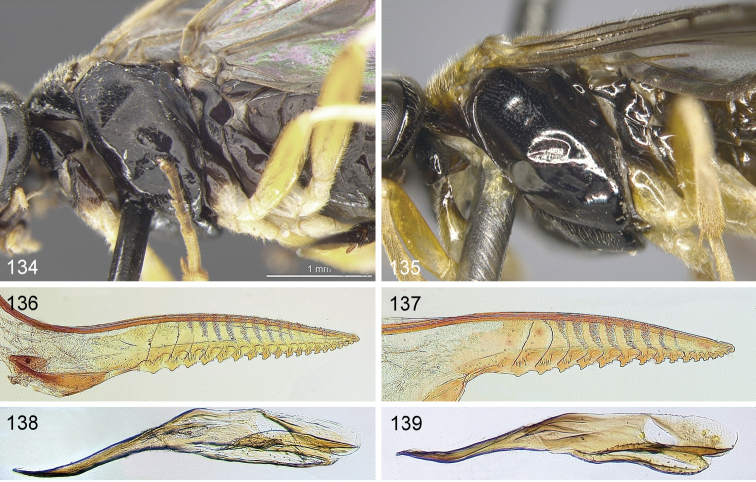
Stauronematus134platycerus DEI-GISHym19761 ♀ lateral 135saliciphilus holotype ♀ DEI-GISHym11427 lateral 136platycerus DEI-GISHym11317 lancet 137saliciphilus DEI-GISHym11427 lancet 138platycerus DEI-GISHym19762 penis valve 139saliciphilus DEI-GISHym11435 penis valve. Scale bar: 1 mm (134).